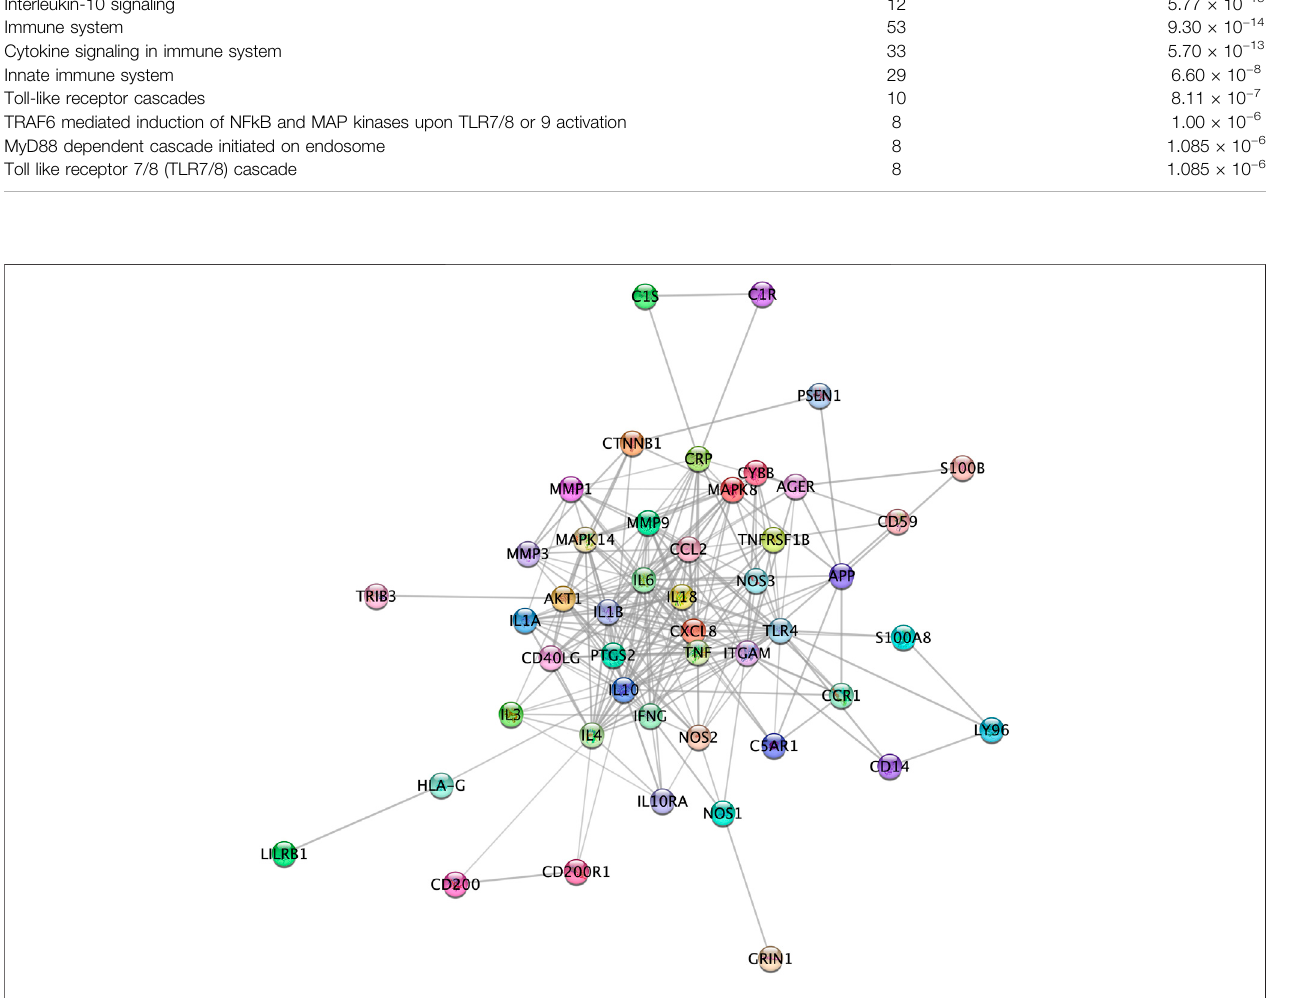
Frontiers in Pharmacology |